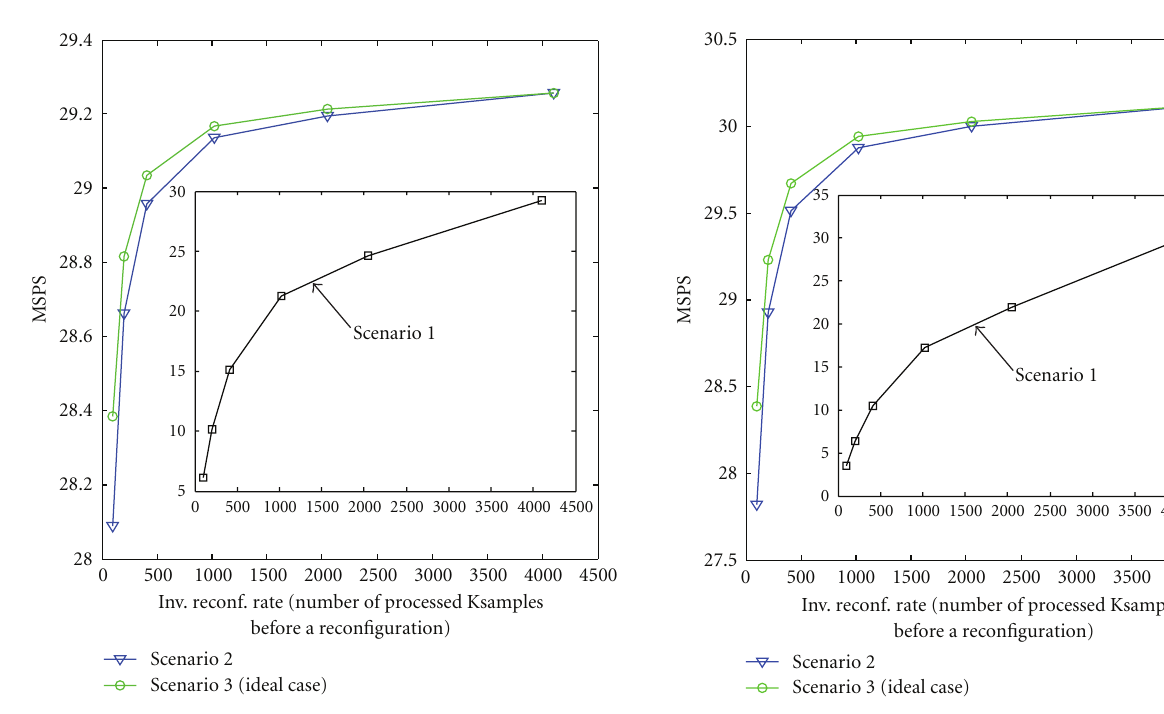
Figure 14: DPR system performance for coe ffi cient-only reconfig- uration.